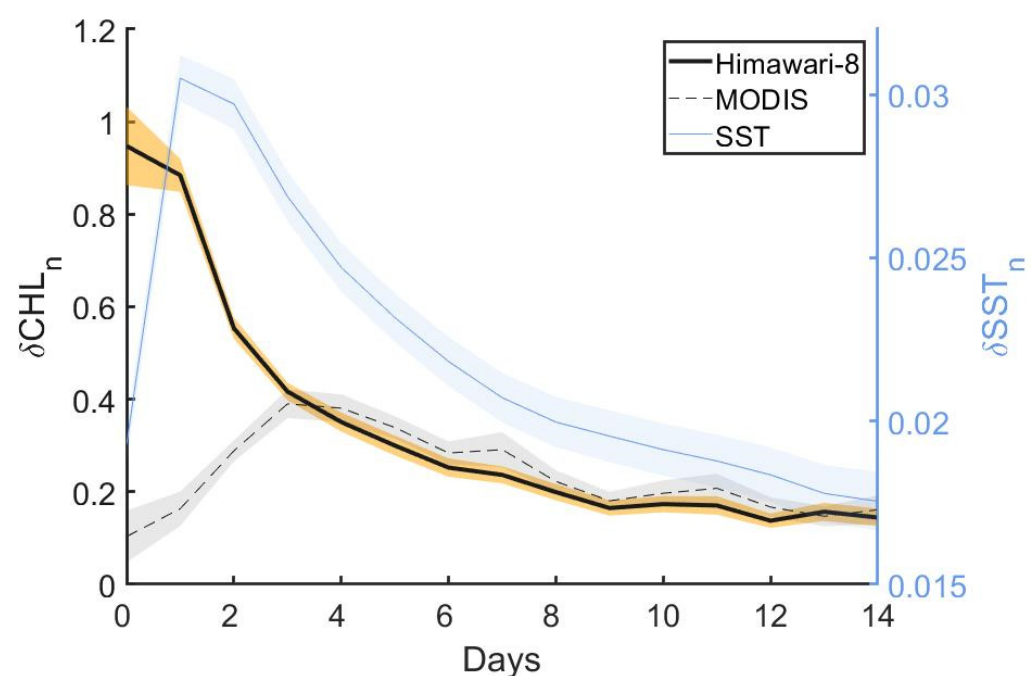
Figure 4. Temporal progression of Chl-a (and SST) changes in response to TC passage with different reacting times. The black solid line shows the results of Himawari-8 AHI observations. The dashed line shows the progression calculated by MODIS observations. The blue line shows the corresponding progression of physical responses (sea surface cooling, − 𝛿 SST 𝑛 ). Shading in different colors denotes the 95% confidence intervals of 𝛿𝐶𝐻𝐿 𝑛 (by AHI and MODIS) and 𝛿 SST 𝑛 corre- sponding to different days.